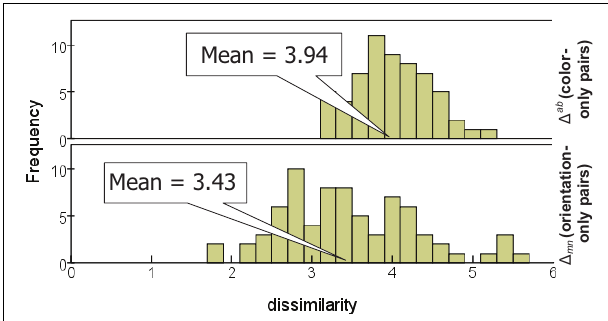
FIGURE 6 | Distribution of dissimilarities for stimulus pairs differing in color only (top) and orientation only (bottom).